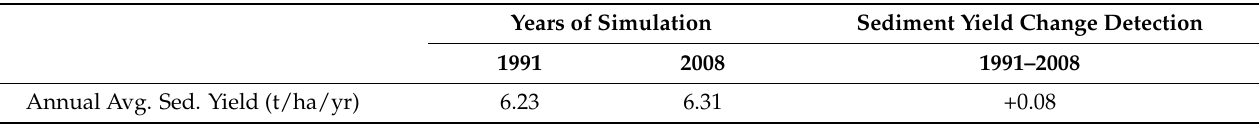
Table 7. Sediment yield result of Koga watershed (1991 and